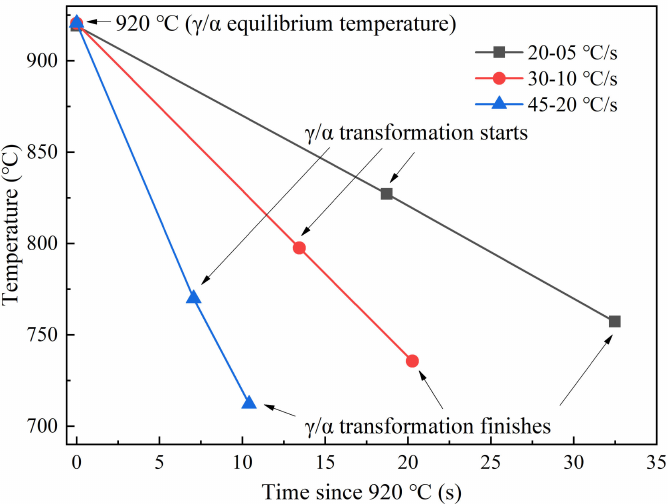
Figure 9. Temperature and duration of phase transformation from austenite to ferrite at different cooling rates. Time = 0 s corresponds to initial transformation temperature from austenite to ferrite at equilibrium